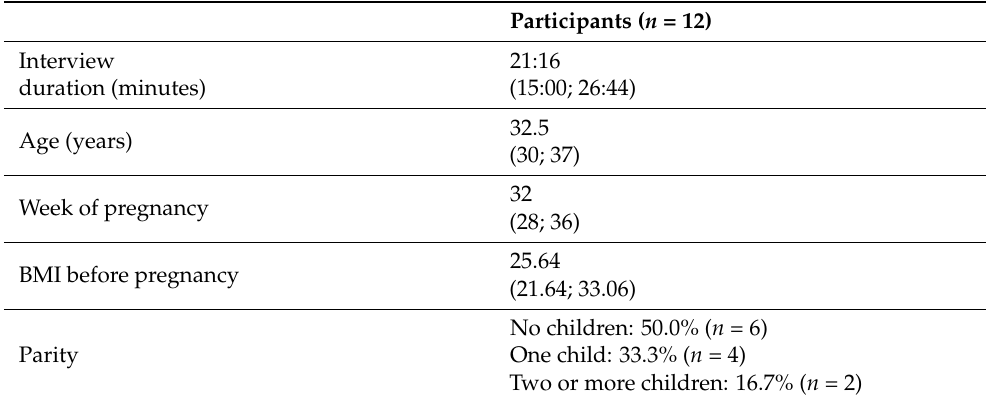
Table 1. Sample description of pregnant women; mean values (minimum;